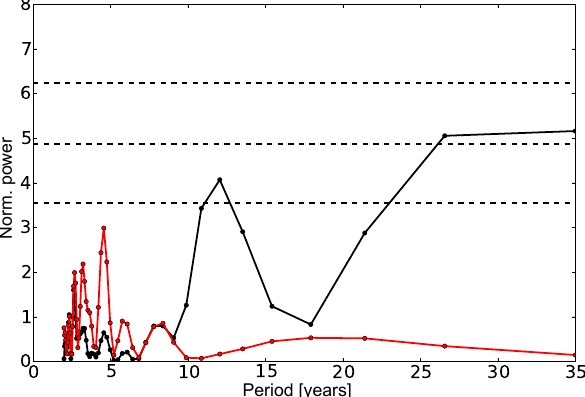
break in the middle of 2008 (BP = (2008.8 ± 1.7) year).